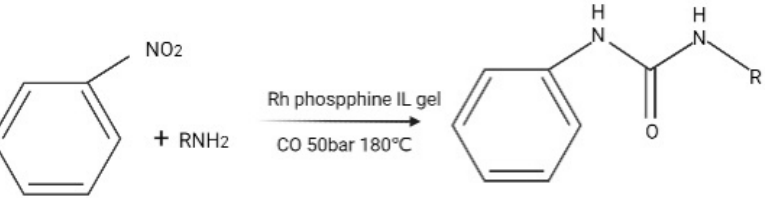
Figure 2. Carbonylation of amines and nitrobenzene catalyzed by metal phosphine-doped IL gels.